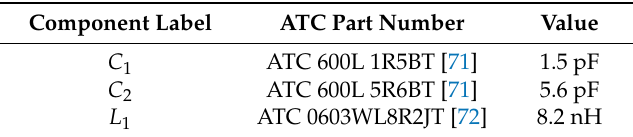
Table 6. List of the component values used in the matching network.